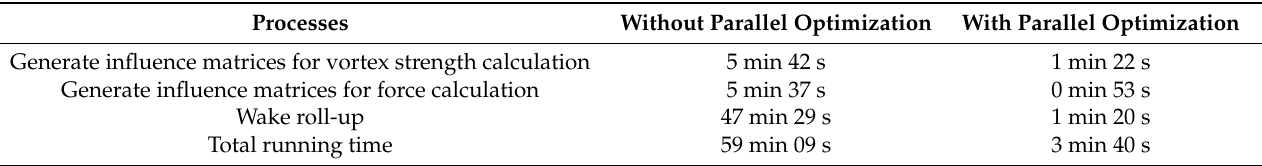
Figure 9. Parallel optimization of influence matrix calculation. Table 1. Comparison of running time before and after parallel